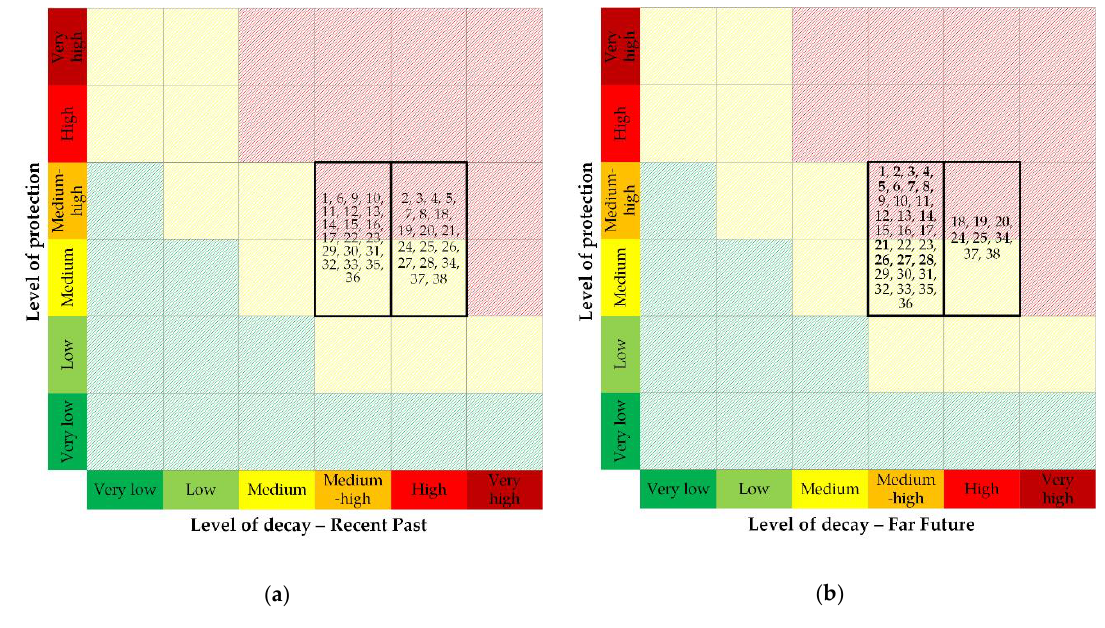
Figure 8. Urgency of interventions in large heavyweight buildings for each ID location in: ( a ) Recent Past (1961–1990); ( b ) Far Future (2071–2100). (Bold IDs in FF: lower decay induced by climate change.).